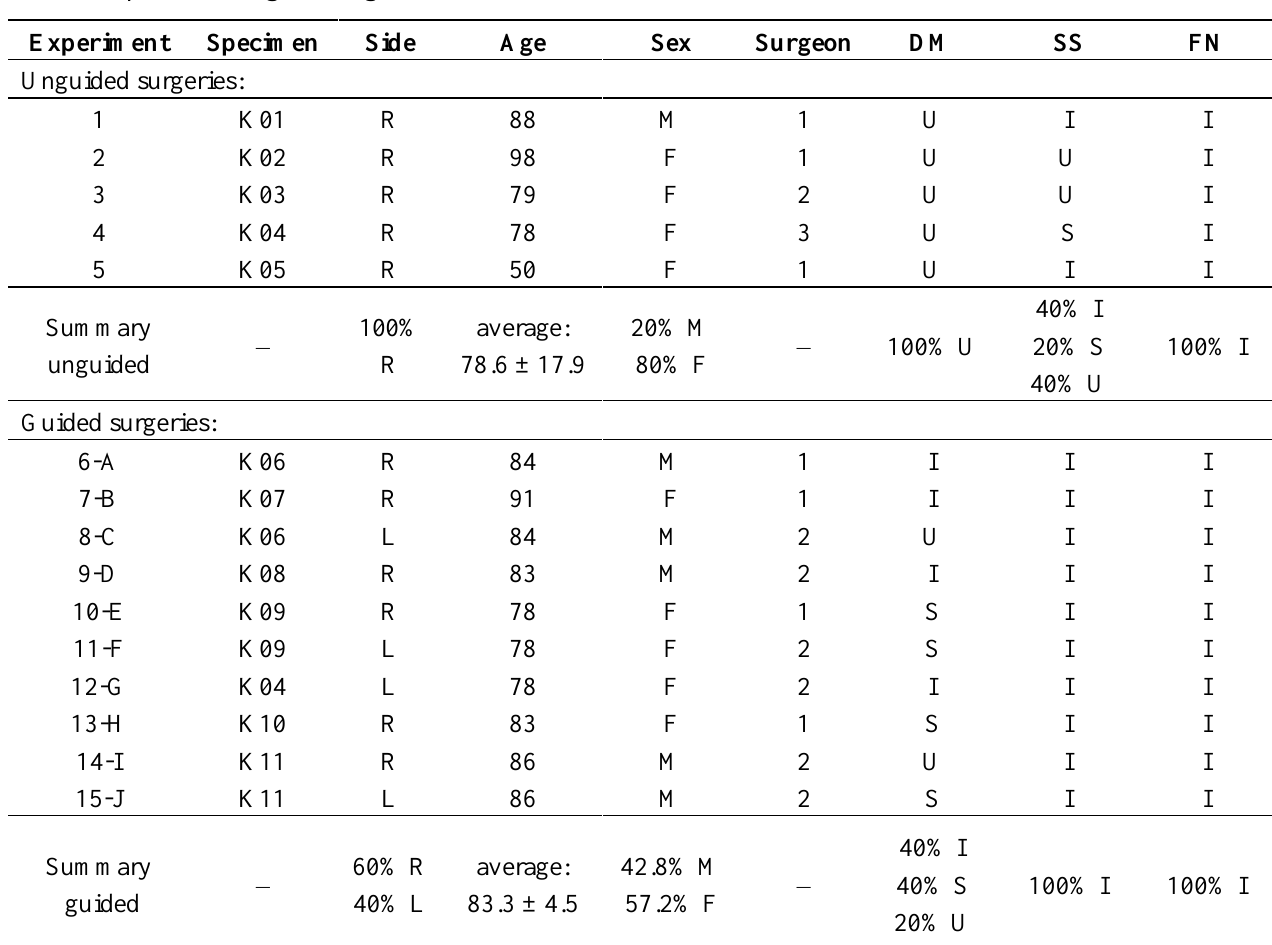
Table 1. List of the experiments. DM: Dura Mater; SS: sigmoid sinus; FN: facial nerve; U: uncovered; S: skeletonized; I: intact. Letters with the experiment number indicate the respective image on Figure 2.